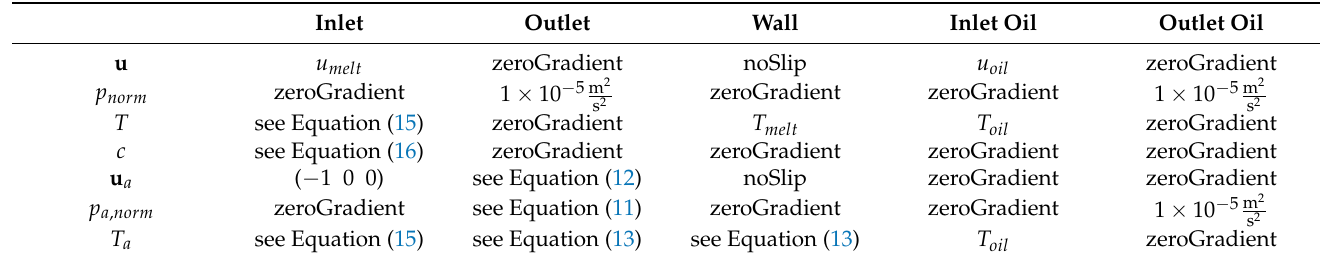
Table 1. Boundary Conditions for CFD simulations.